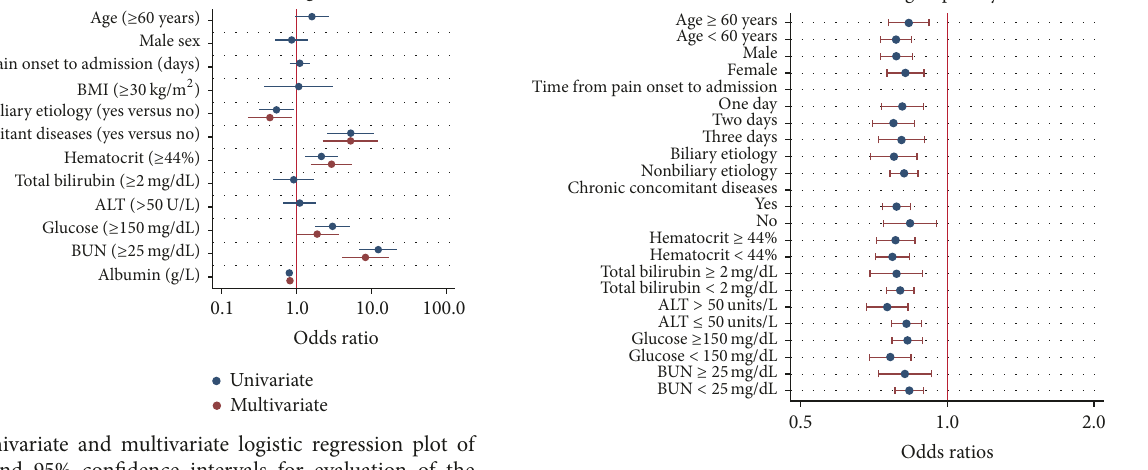
Figure 4: Logistic regression plot of odds ratios and 95% confidence intervals; subgroup analysis of relationship between serum albumin level and risk of persistent organ failure in acute pancreatitis.